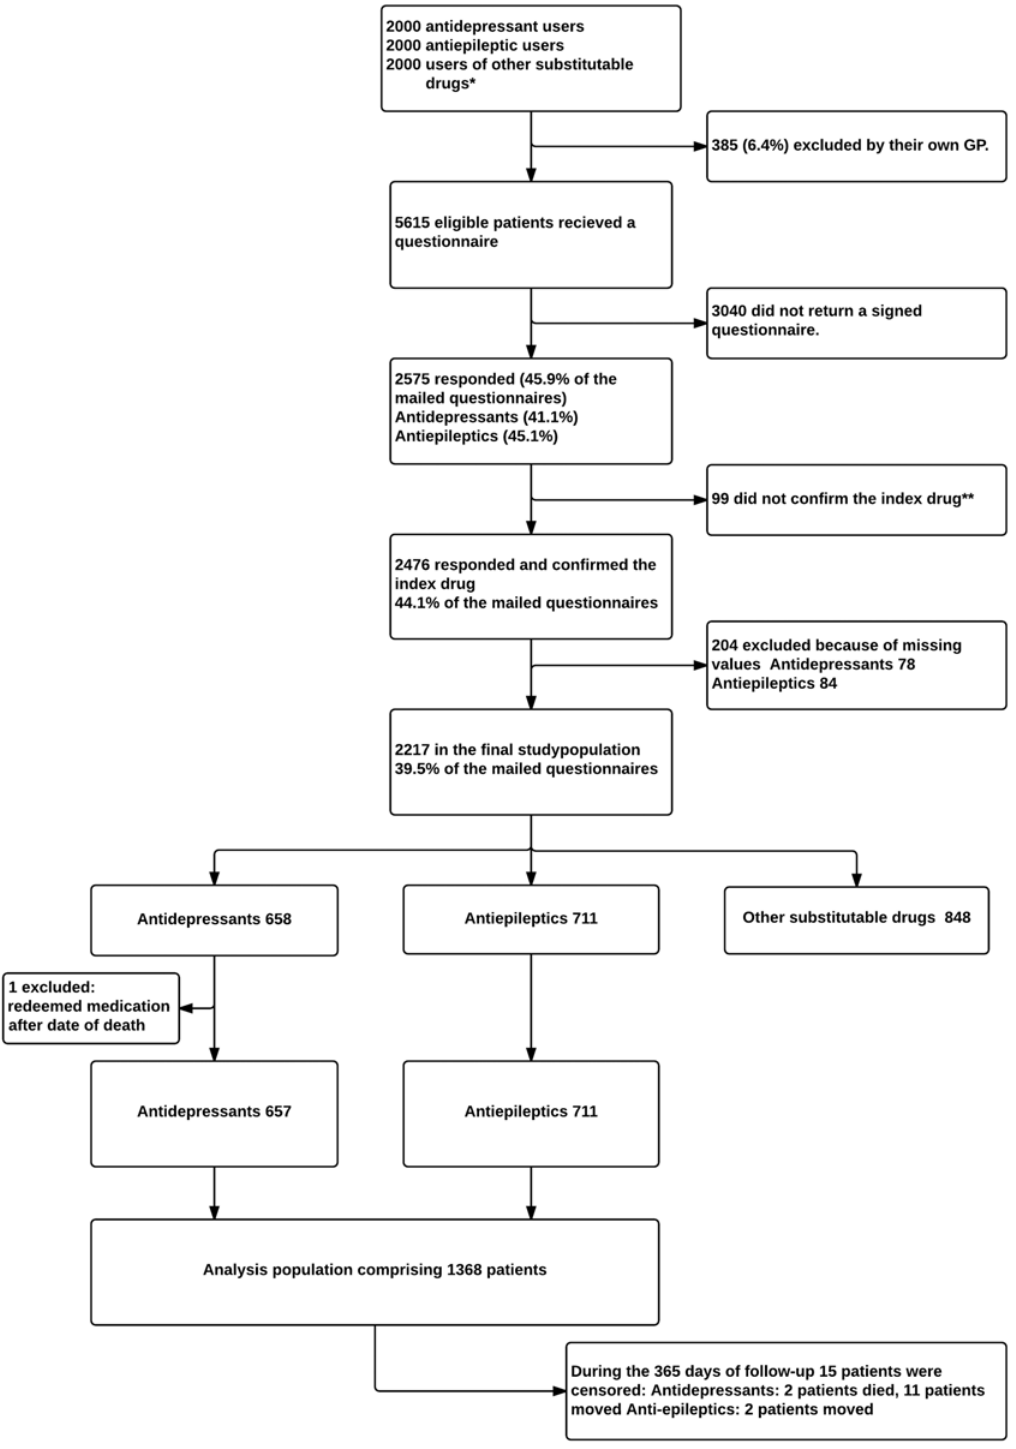
Fig 1. Flowchart of the postal survey process. Generic switch is defined as a purchase of a drug different from the patients ’ previously purchased drug within the same ATC code. * “ Other substitutable drugs ” : consisted of a wide range of medicines considered as a random sample of what is used for long- term treatment; ** Index drug: the purchase of a generically substitutable drug in September 2008 (index date); +GS: experienced a generic switch;-GS: did not experience a generic switch